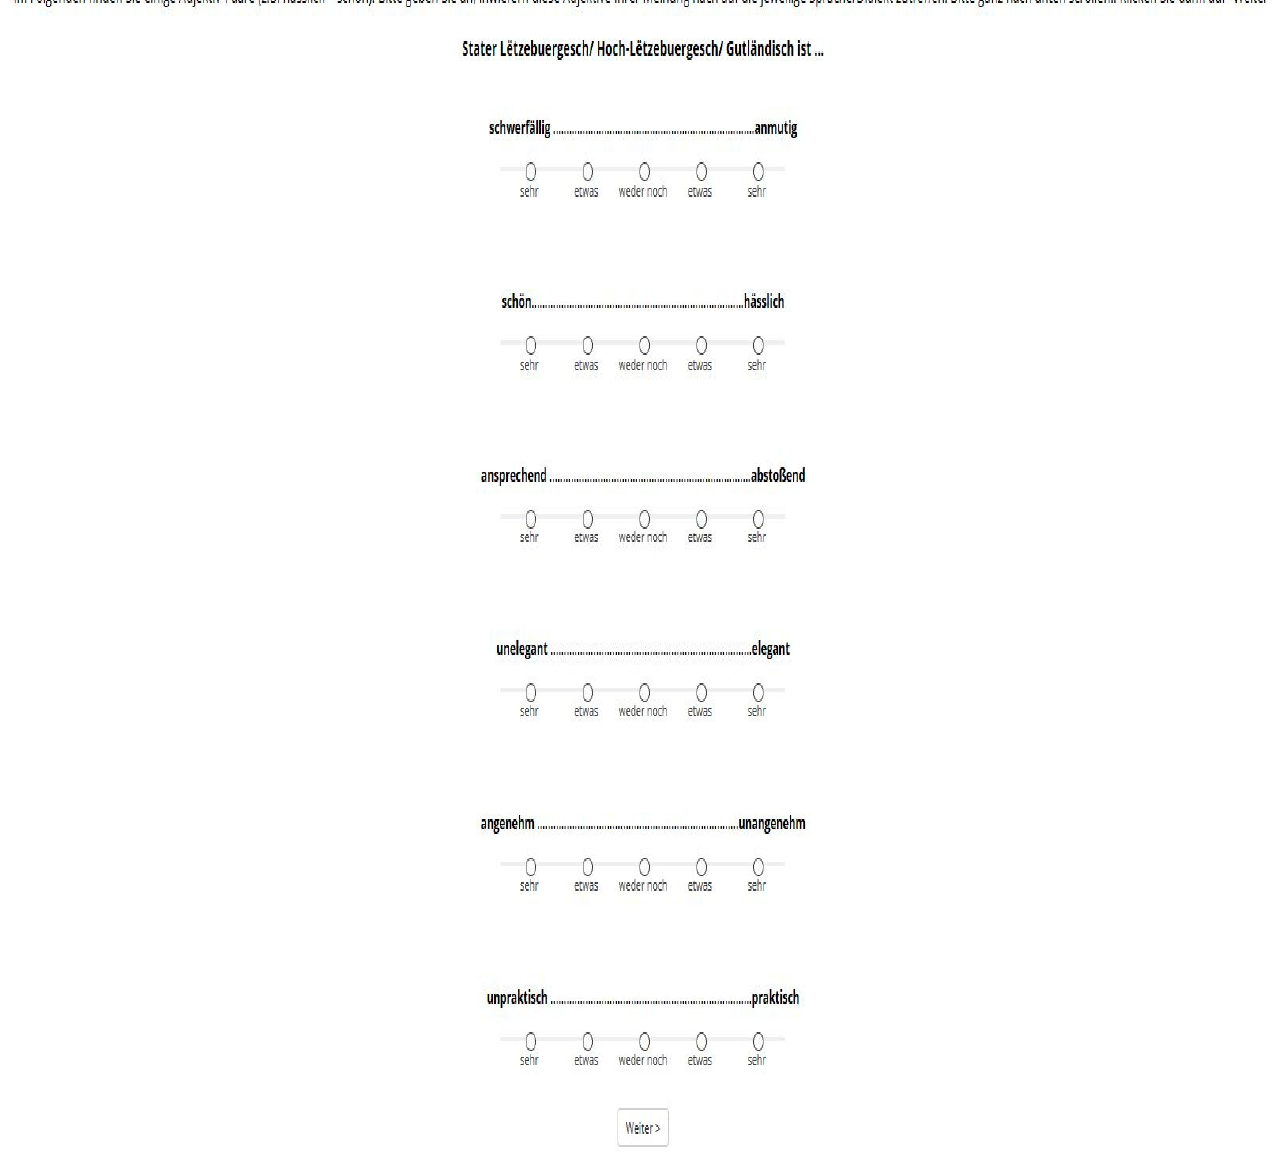
Figure A3. Semantic differential scales to measure attitudes towards Standard Luxembourgish in Luxembourg.